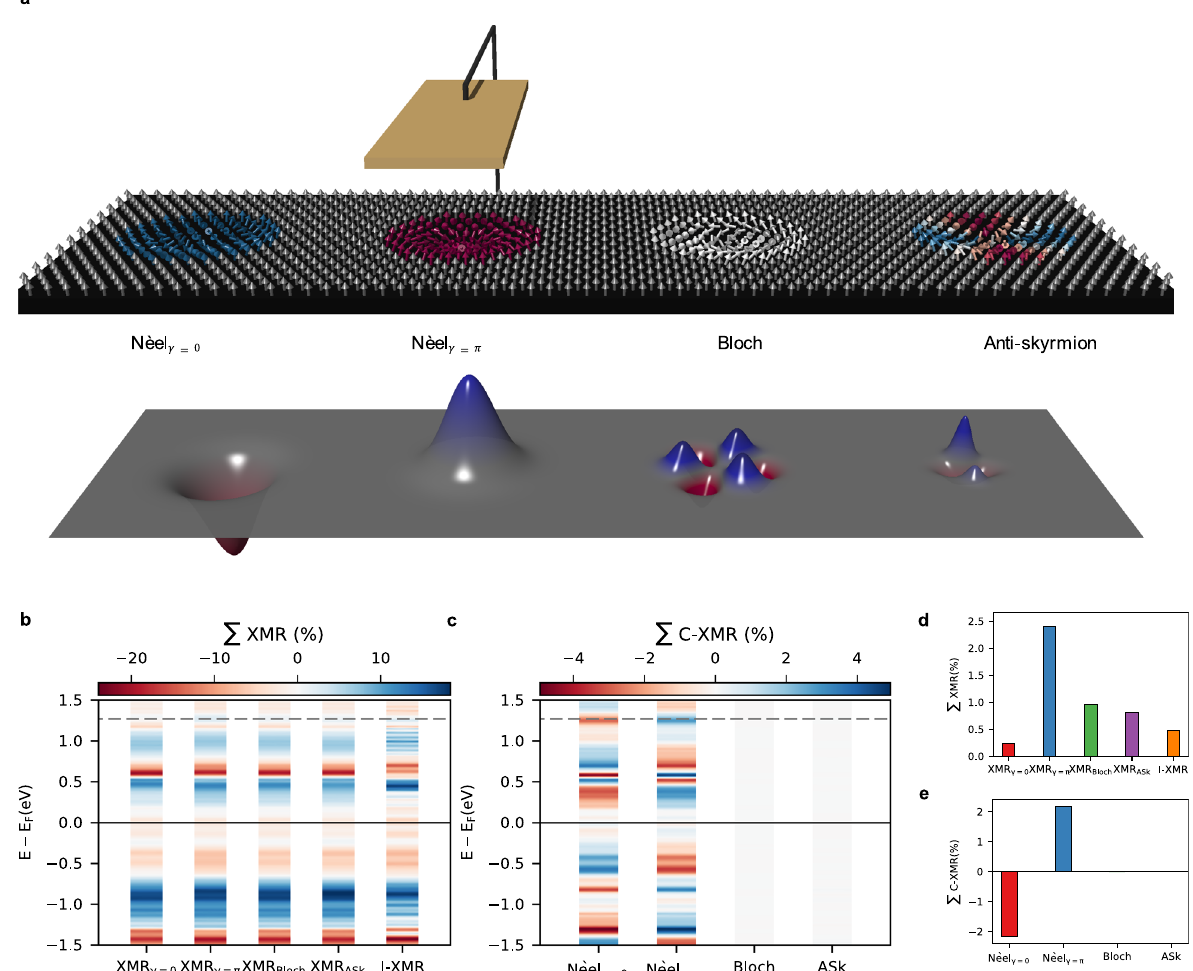
Fig. 6 Concept for all-electron detection of various skyrmions passing in a racetrack device. a If the electrode provides atomic resolution, the C-XMR shows very distinct pro fi les as obtained at the tunneling energy eV bias = 1.27 eV. Note the sign change for Néel skyrmions of opposite helicity. b , c If the electrode lacks atomic resolution, the detected signal is collected over the area encompassing the skyrmion. The bias-resolved signal is plotted for the total XMR, I-XMR, and C-XMR signals. d , e show a comparison of the total XMR and C-XMR ef fi ciencies obtained at eV bias = 1.27 eV (dashed lines in b , c